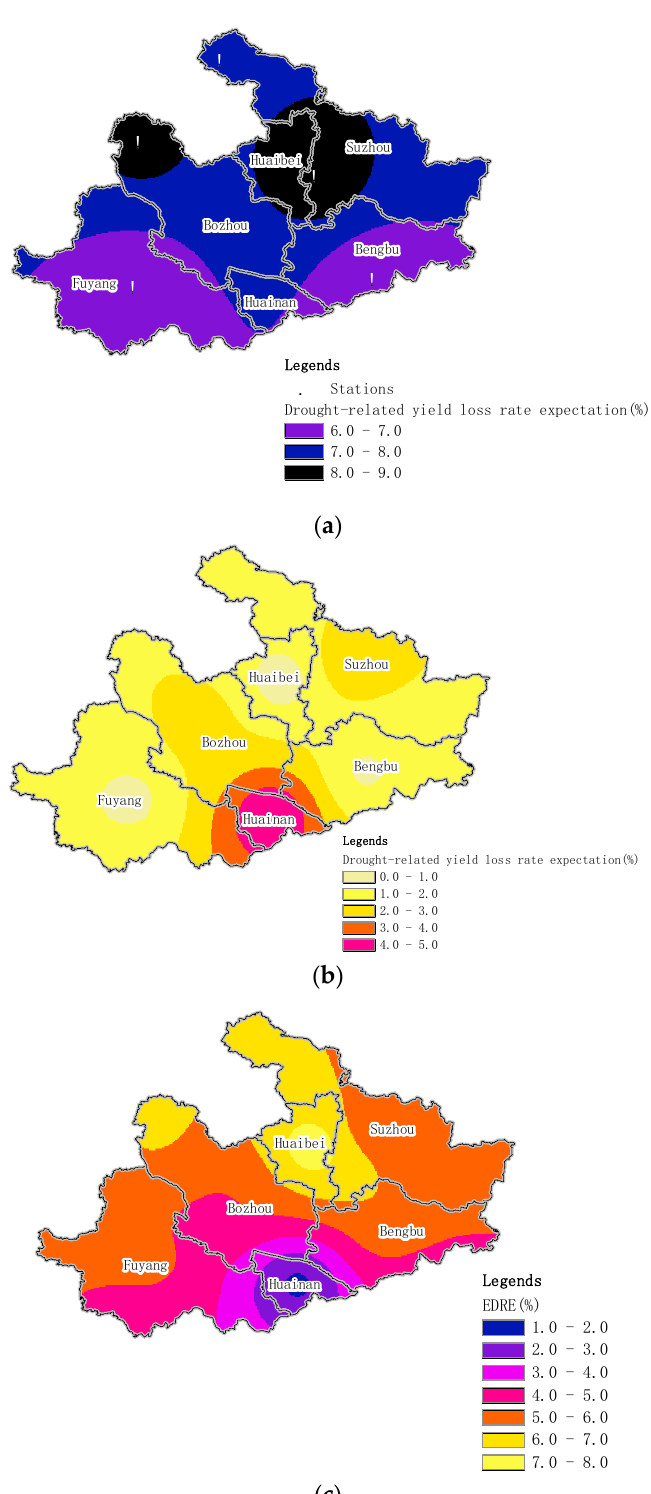
Figure 4. The drought-related yield loss rate expectation distribution of wheat ( a ) without drought mitigation measures (EDRL) and ( b ) under actual drought mitigation measures (EDRM); and ( c ) the expectation distribution of the drought mitigation effects index (EDRE).